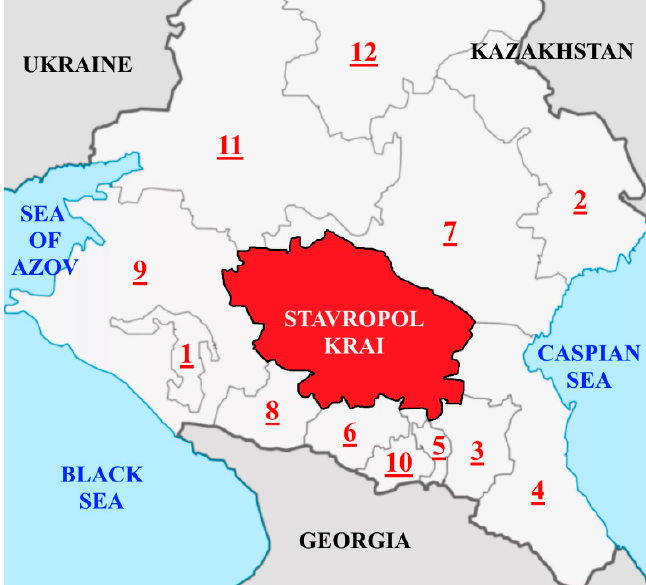
Figure 1. Map of Central Fore-Caucasus. Note: 1 = Adygeya; 2 = Astrakhan; 3 = Chechnya; 4 = Dagestan; 5 = Ingushetia; 6 = Kabardino-Balkaria; 7 = Kalmykia; 8 = Karachaevo-Cherkessia; 9 = Krasnodar; 10 = North Osetia-Alania; 11 = Rostov; 12 = Volgograd. Source: authors’ development.